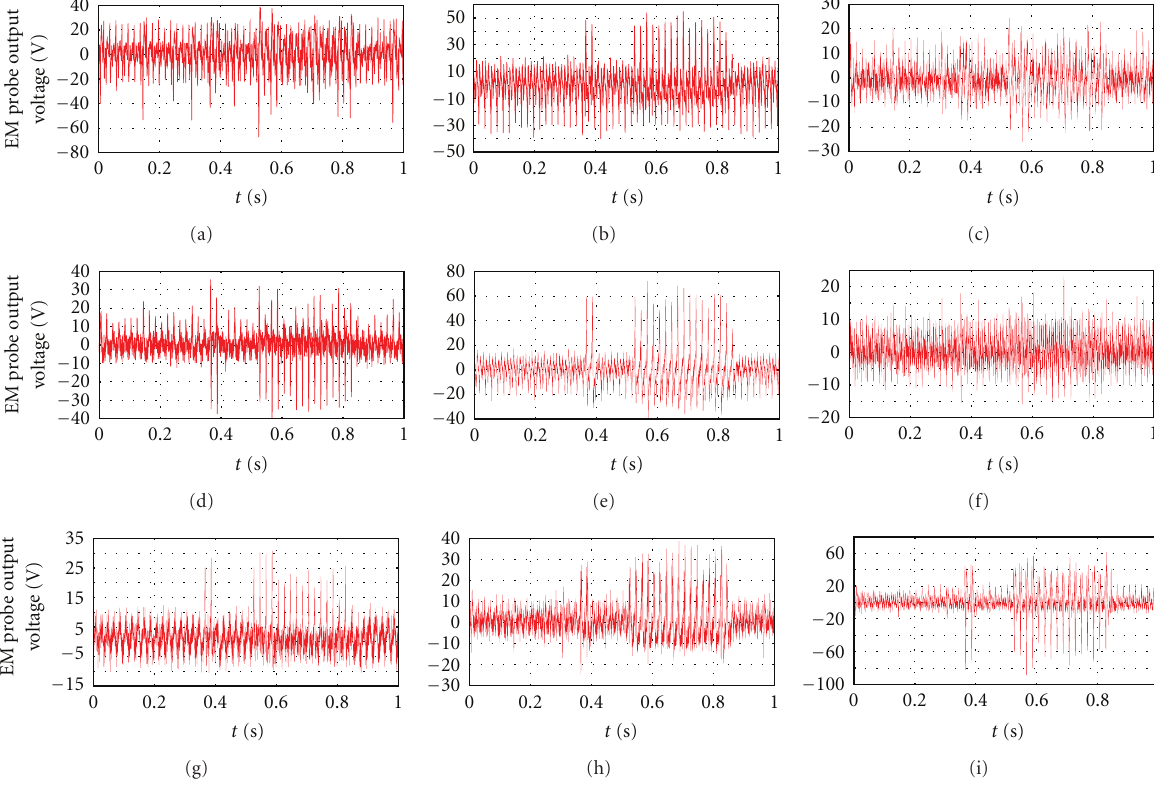
Figure 7: Output voltage of the EM probe when positioned over the points of interest.